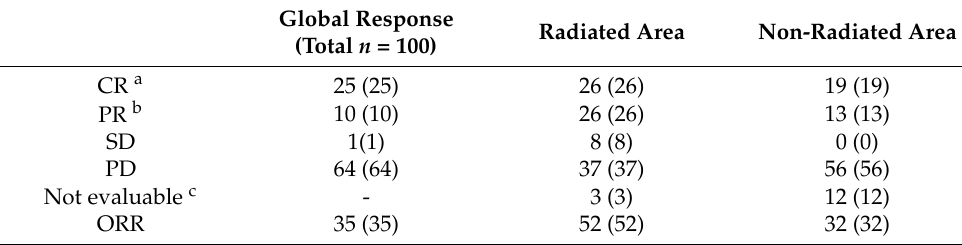
Table 3. Best response after radiotherapy and anti-PD-1 monoclonal antibodies combination in melanoma patients who failed anti-PD-1 monotherapy or with rapidly progressing disease at anti- PD-1